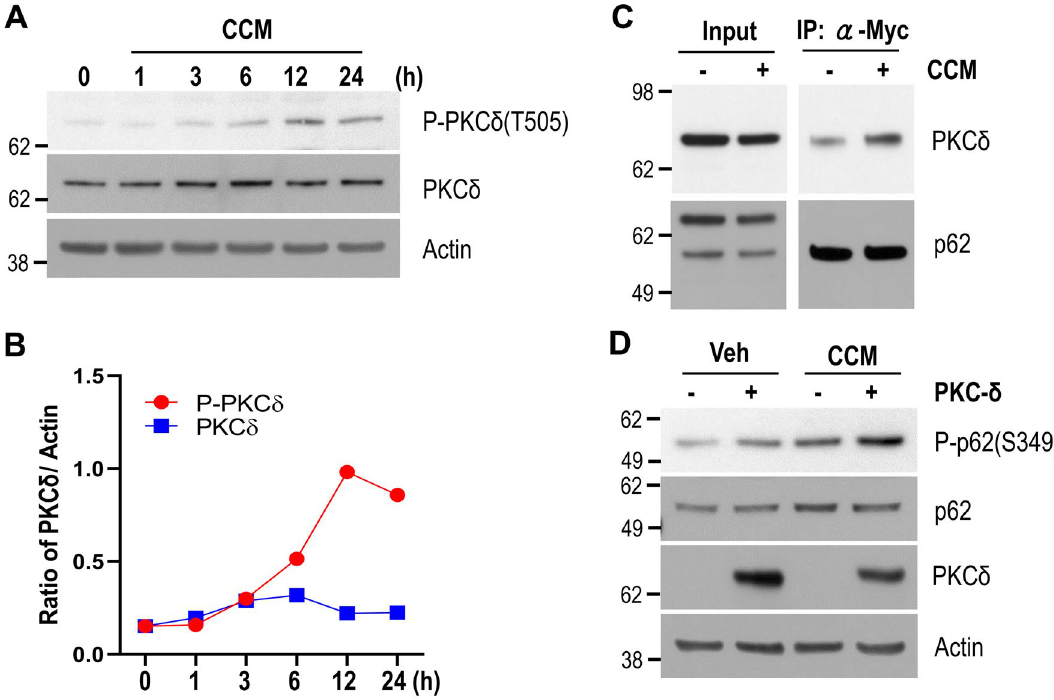
Figure 5. Curcumin activates PKCδ. ( A ) Mouse cortical cells were treated with DMSO (0 h) or 10 μM curcumin (CCM) for the indicated times. The levels of PKCδ phosphorylation at T505 was analyzed by immunoblotting using an anti-phospho PKCδ (T505) antibody. The protein levels of PKCδ and actin were analyzed by immunoblotting using anti-PKCδ, and actin antibodies, respectively. ( B ) The line graph shows the relative ratio of phosphorylated PKCδ at T505 or PKCδ normalized to that of actin. ( C ) HEK293 cells were transiently transfected with Myc-p62 and HA-PKCδ expression plasmids, and then treated with DMSO (−) or 10 μM curcumin (+) for 6 h. The cell lysates were used for p62 immunoprecipitation using an anti-Myc antibody. The protein level of PKCδ co-immunoprecipitated with p62 was examined by immunoblotting using an anti-HA antibody. ( D ) HEK293 cells were transiently transfected with the HA-PKCδ expression plasmid and treated with DMSO (Veh) or 10 μM curcumin (CCM) for 12 h. The levels of phosphorylated p62 (S349), p62, PKCδ, and actin proteins were examined by immunoblotting using anti-phospho p62 (S349), p62, HA, and actin antibodies, respectively. Full blots are provided in Supplementary Fig.